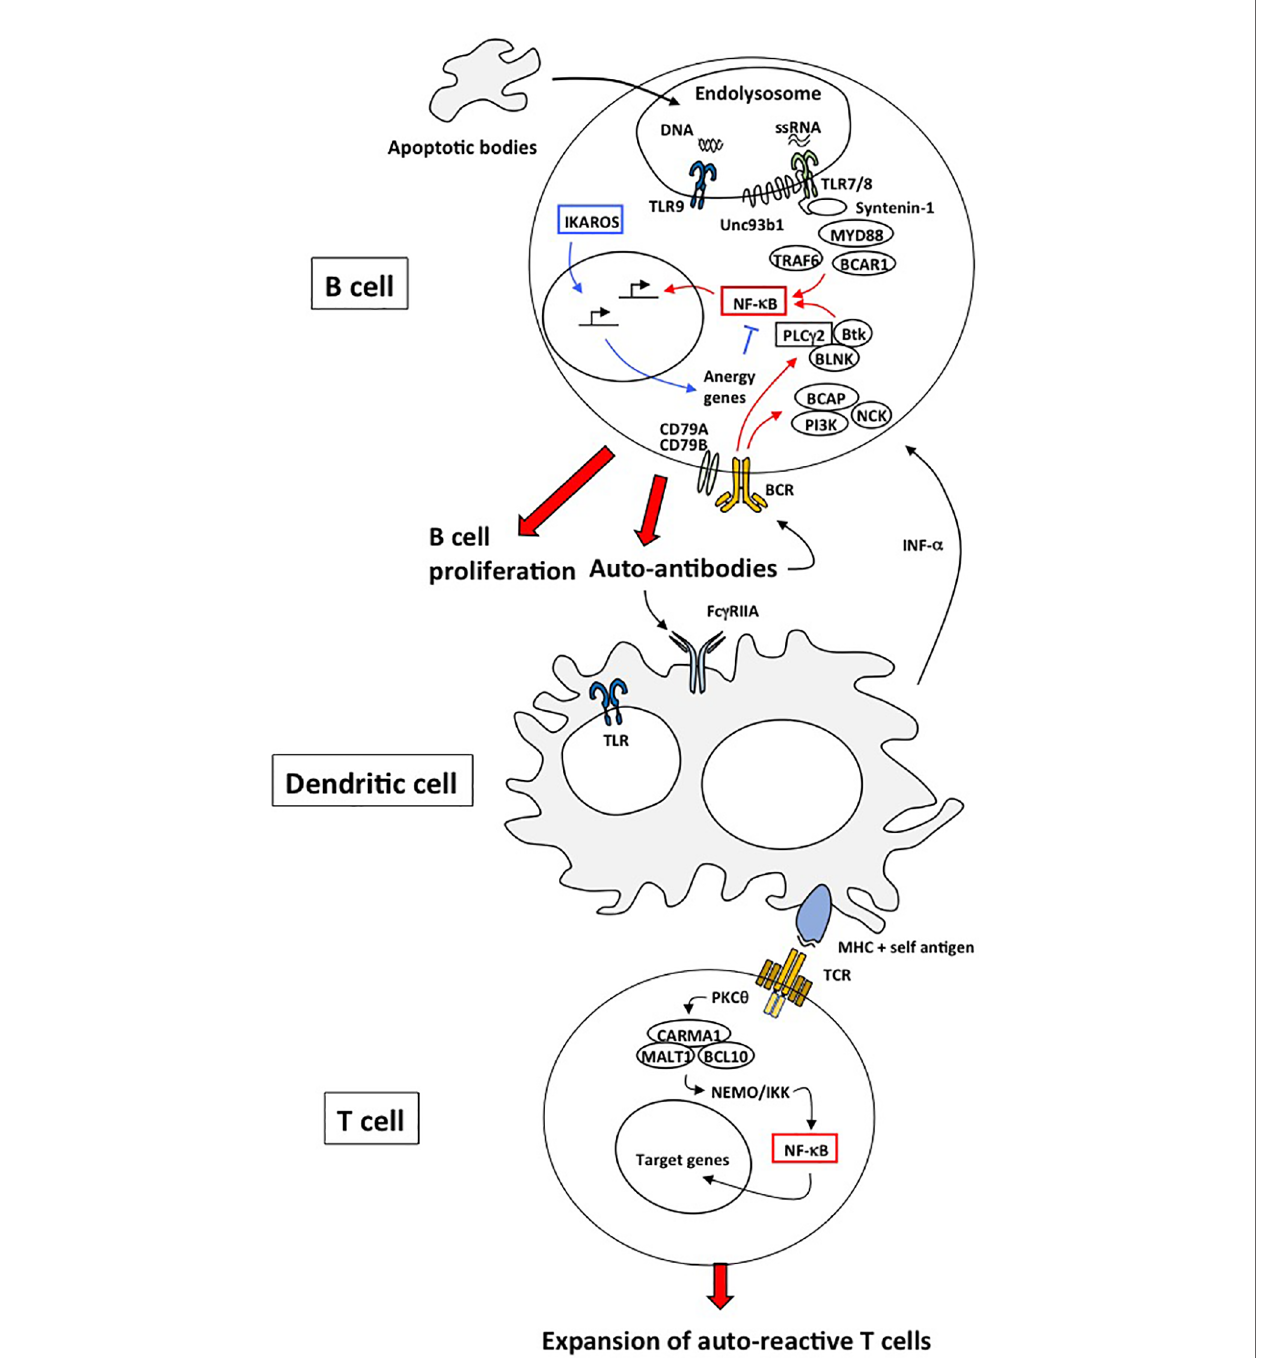
FIGURE 1 | Mechanisms responsible for autoimmunity involving TLRs, BCR and TCR. In B cells, defective clearance of apoptotic cell debris releases nucleic acids capable of activating endosomal TLR7 and TLR9. TLR7- and TLR9-mediated NF- k B activation is dependent on MyD88, IRAK family of kinases and TRAF6. The chaperone UNC93B1 limits TLR7 signaling through its interaction with Syntenin-1 but not TLR9 and thus prevents TLR7-mediated autoimmunity. These TLR receptors can operate in conjunction with the BCR to activate NF- k B in order to increase the production of antibodies. Another transcription gene, Ikaros, induces the expression of anergy genes of which certain inhibit NF- k B. As a consequence, mutations of Ikaros or anergic genes can be responsible of autoimmune diseases. Dendritic cells induce peripheral tolerance by directing the fate of antigen-speci fi c T cells. DCs can present self-antigens to T cells, providing transient T cell activation that can lead to either anergy or deletion of these T cells. DC-mediated tolerance is thus an active process that requires TCR-mediated NF- k B